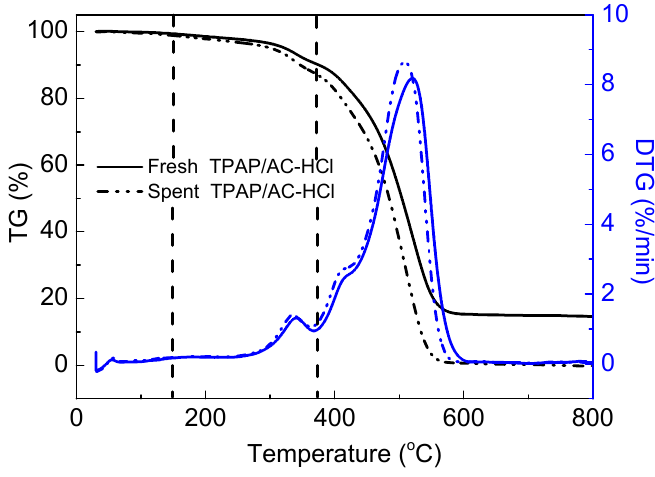
Figure 3. TG (Thermogravimetric) curves of the fresh and spent TPAP/AC-HCl